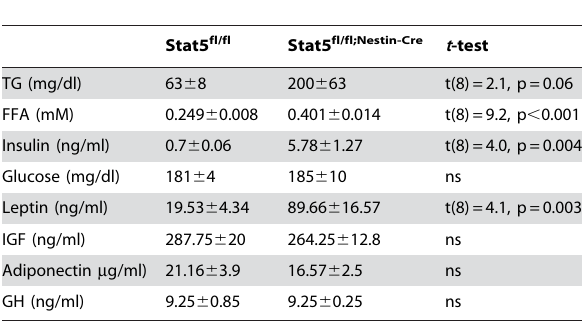
Table 1. Metabolic parameters in serum